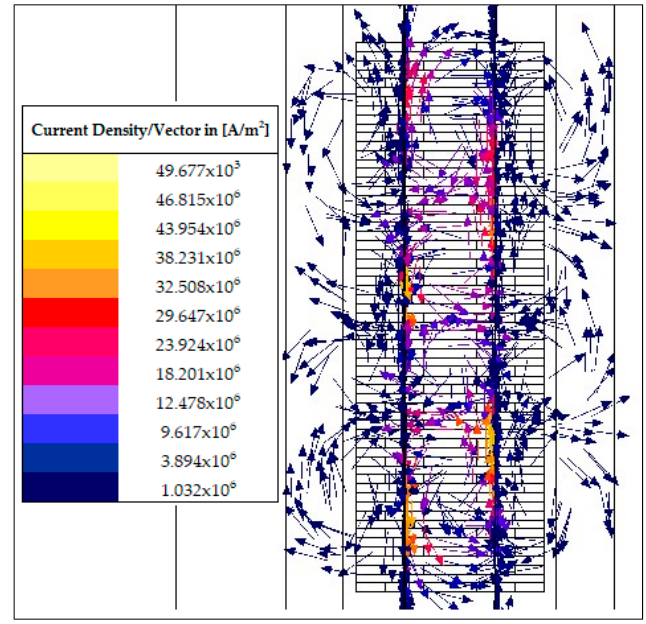
Figure 16. Spatial distribution of eddy currents in model 2.